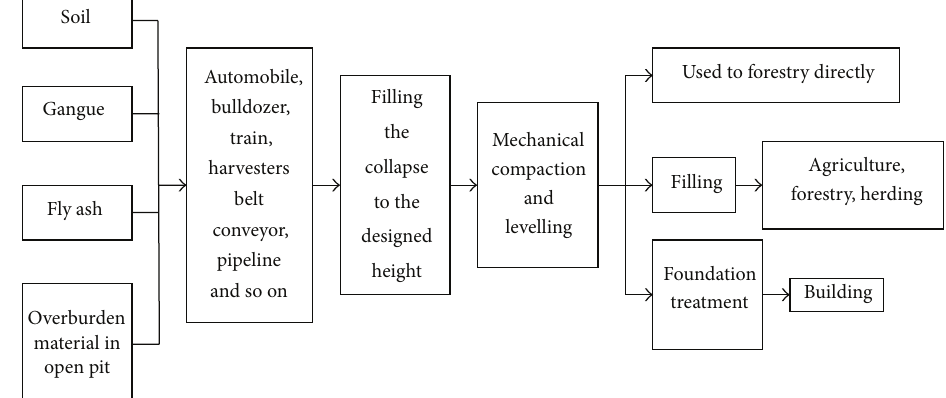
Figure 2: The industrial and mining area filling reclamation process flow